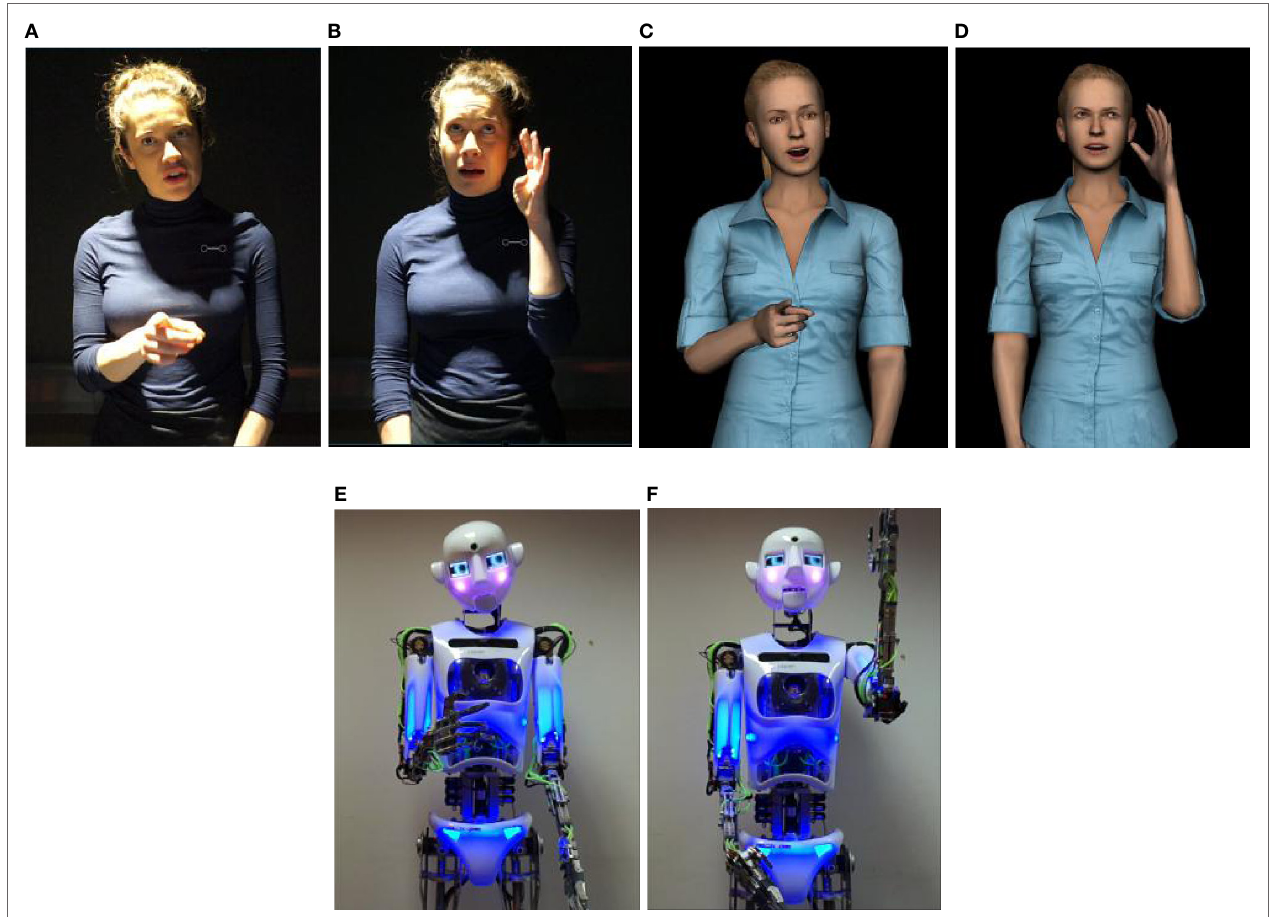
FigUre 2 | examples of stimuli for different media representations and expertise . (a) Video expert, (B) video non-expert, (c) avatar expert, (D) avatar non-expert, (e) robot expert, and (F) robot